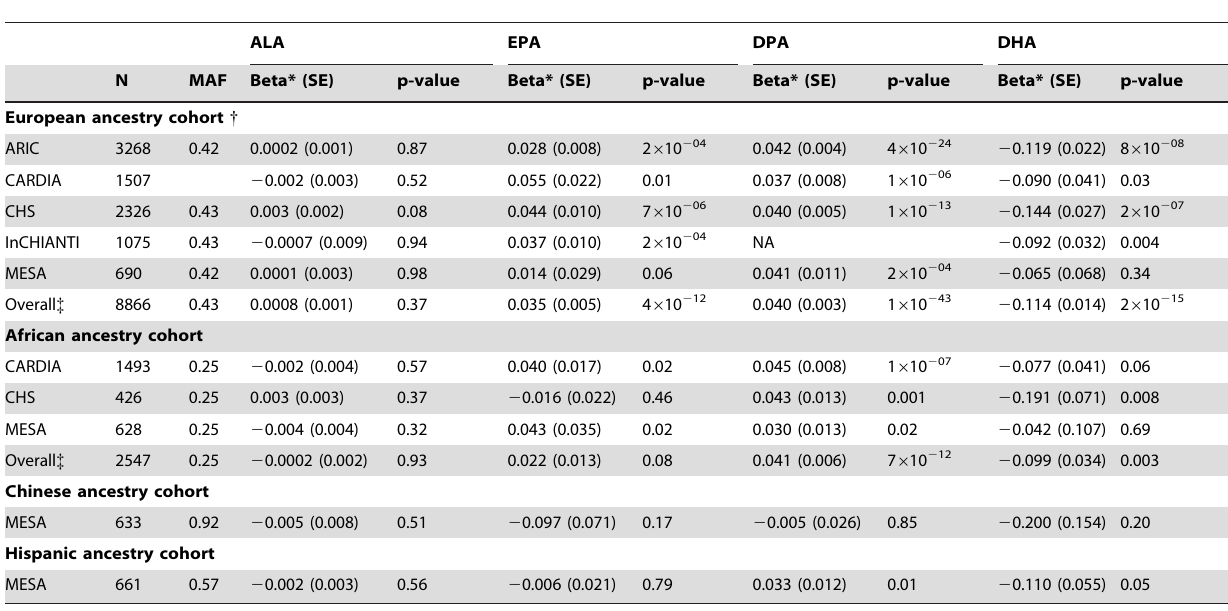
Table 4. Associations of rs3734398 (C allele) with n-3 polyunsaturated fatty acids in samples of different ancestries.